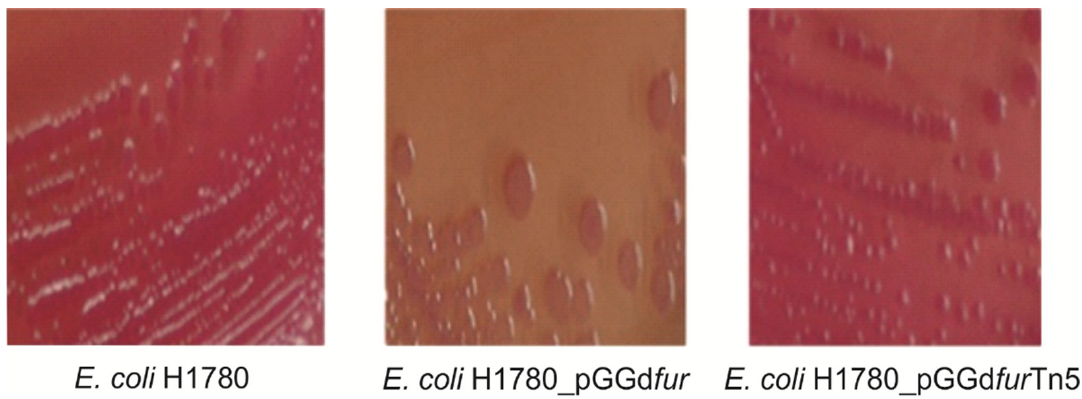
Figure 8. Fur Titration Assays (FURTA). Complementation of an E. coli fur mutant H1780 by G. diazotrophicus fur homologs. β -Galactosidase activity of E. coli H1780 cells containing the indicated plasmid plated in McConkey medium with 30 µM Fe supplement. All determinations are the means of at least three experiments, each in triplicate (Leica L2 stereoscope, magnification ×16).